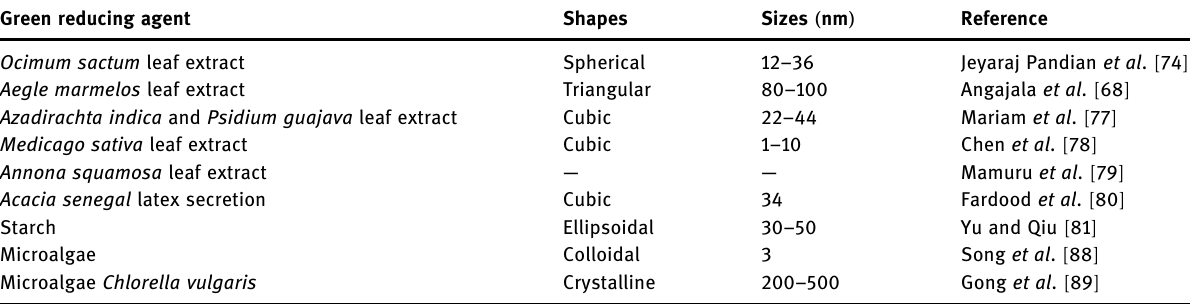
Table 4: Green reducing agents in the synthesis of Ni nanoparticles with shapes and sizes Green reducing